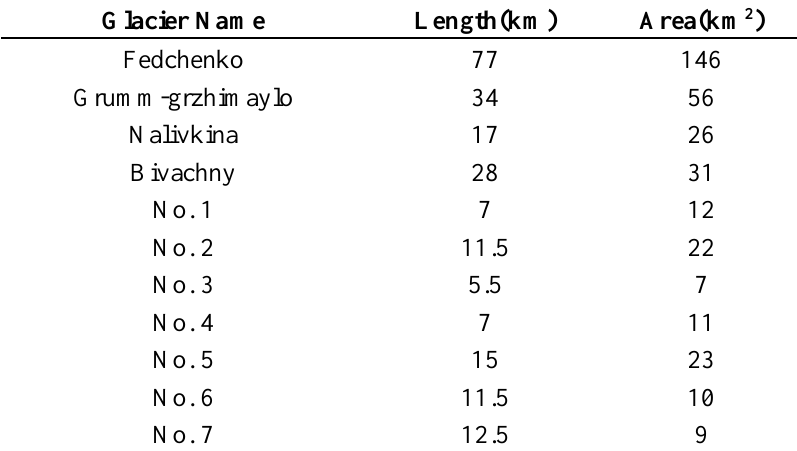
Table 1. The basic information of some glaciers in study